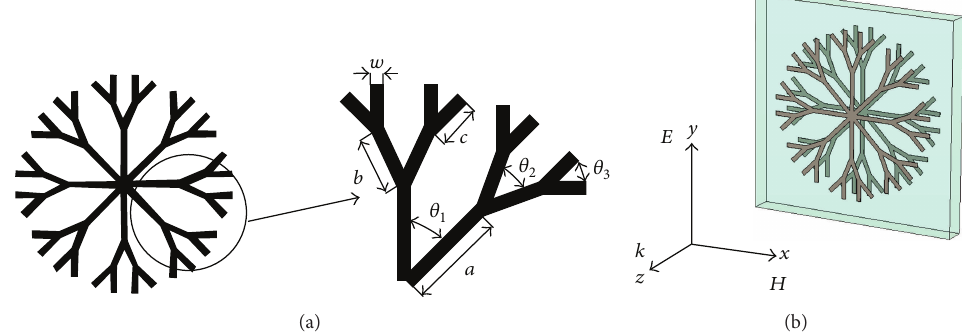
Figure 1: (a) Unit cell of dendritic structure; (b) schematic for 𝑆 -parameter simulation.